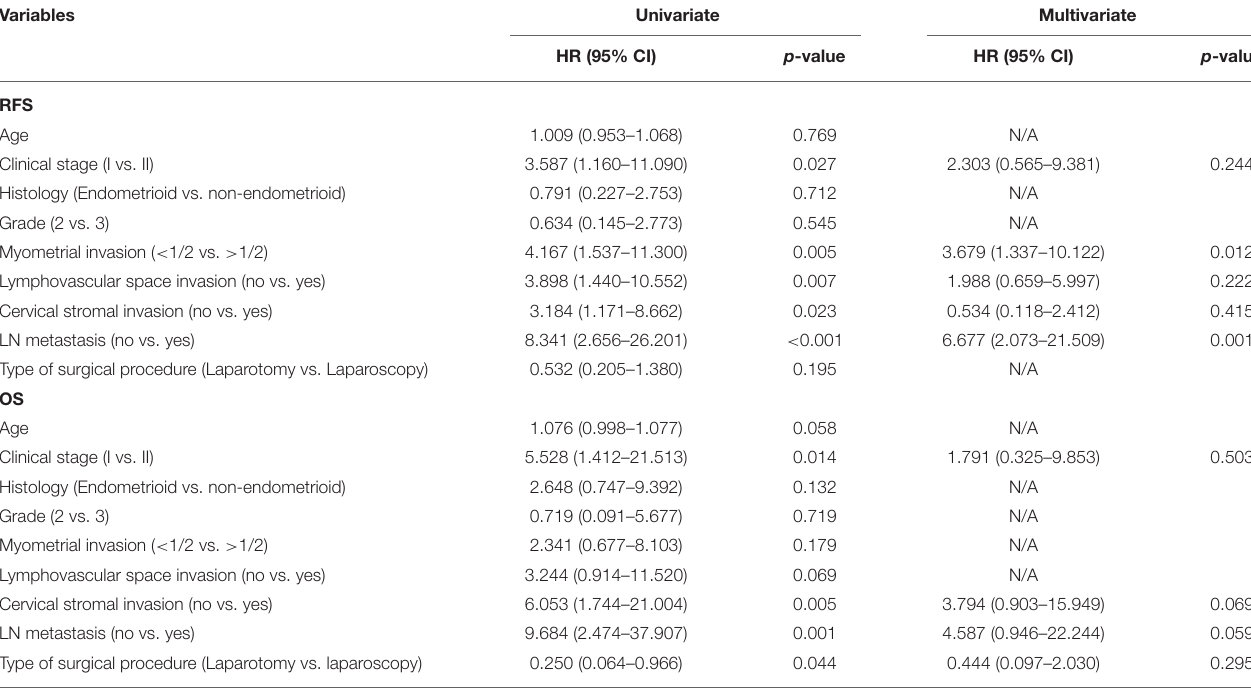
TABLE 5 | Univariate and multivariate Cox proportional hazards analysis for recurrence-free survival (RFS), and overall survival (OS) to adjust risk associated with prognostic features.